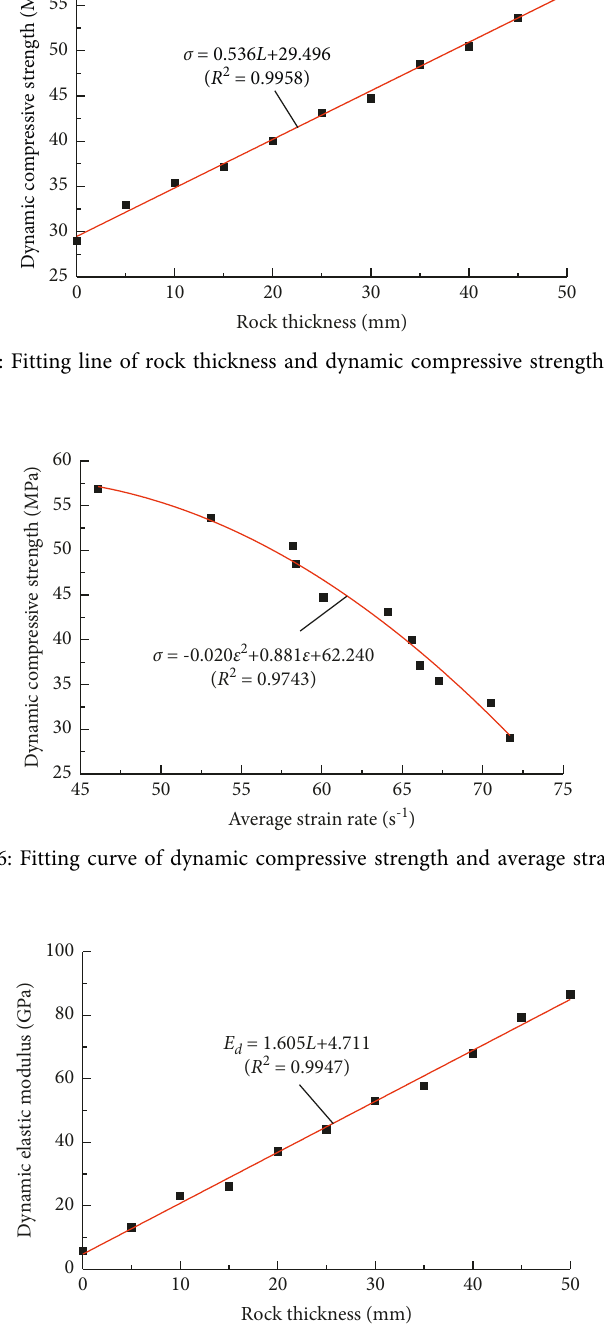
Figure 7: Fitting line of relationship between rock thickness and dynamic elastic